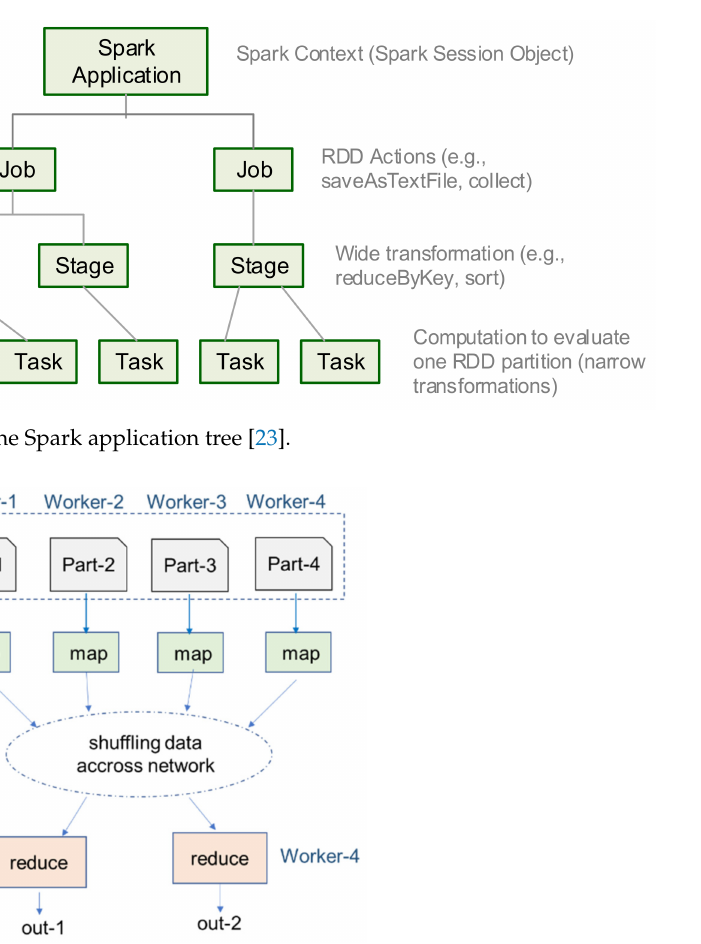
Figure 2. Illustration of shuffling for a stage on a Spark cluster with four workers: each worker stores one RDD partition and runs a map task, then two reducer tasks on two workers process data from map